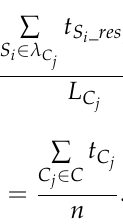
of all controllers C j ∈ C , as shown in Equation j